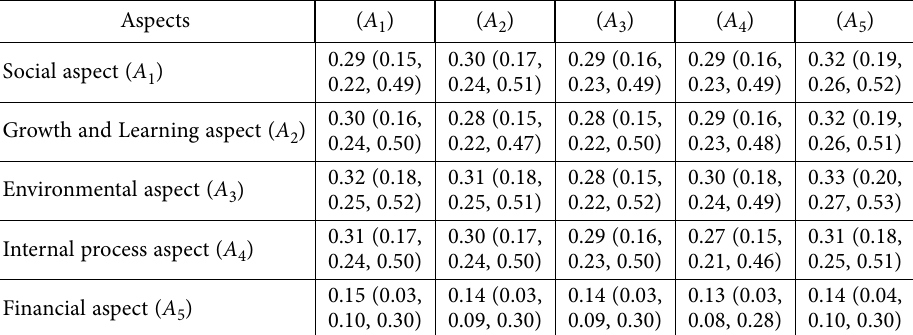
Table 4. The sum of effects on aspects with fuzzy number and defuzzication Aspects